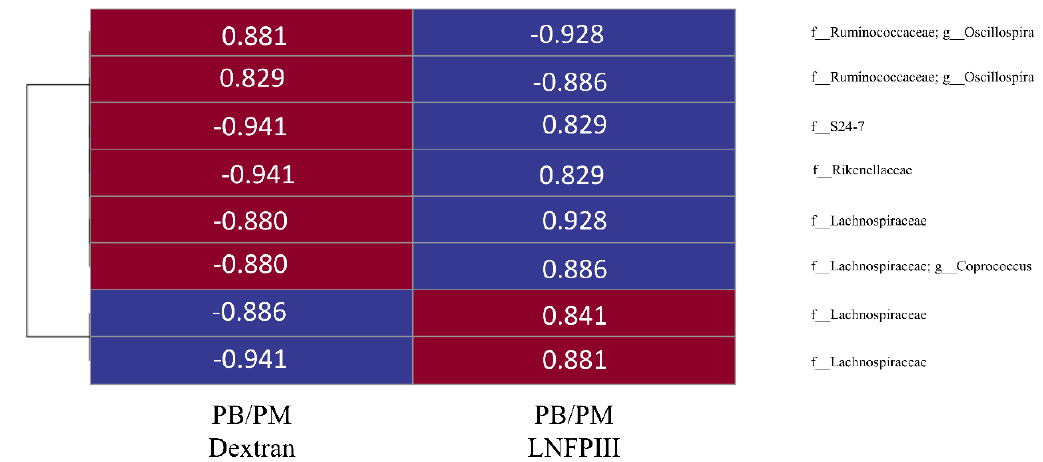
Figure 8. Heat map representing the relative bacterial abundance (OTUs) belonging to families specified to the right of the figure that were significantly ( p < 0.05) correlated with the fastest sticker removal time (sec) in mice exposed to PB / PM-Dextran (left column) or PB / PM-LNFPIII (right column). White numerals indicate the correlation coe ffi cient between relative abundance and fastest removal time for each respective OTU. The “f_” indicates family level and “g_” indicates genus level of taxonomic ranks. If no genus is provided, the OTU was unclassified at the genus level. Red boxes indicate increased and blue color indicate decreased relative abundance of each family / genus OTU in that respective treatment group (column). No sign in front of the number indicates it is a positive correlation coefficient, whereas a negative sign indicates a negative correlation coefficient.